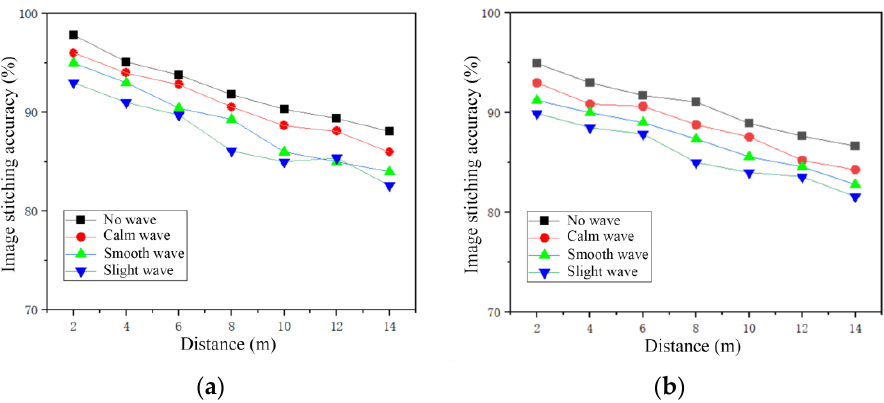
Figure 22. Experimental results of image stitching accuracy. ( a ) Image stitching accuracy of the obstacle 1. ( b ) Image stitching accuracy of the obstacle 2.